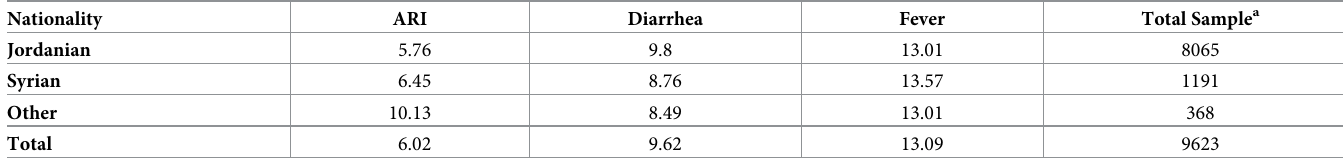
Table 2. Sample size distribution of acute respiratory infection, diarrhea and fever by nationalities among under-five children in Jordan,